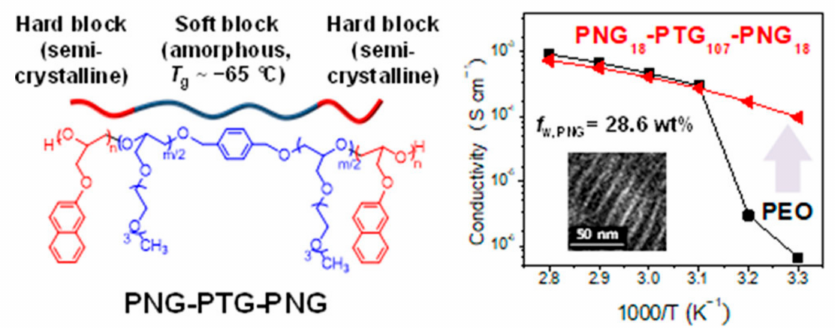
Figure 1. Chemical structure and ionic conductivity of PNG–PTG–PNG